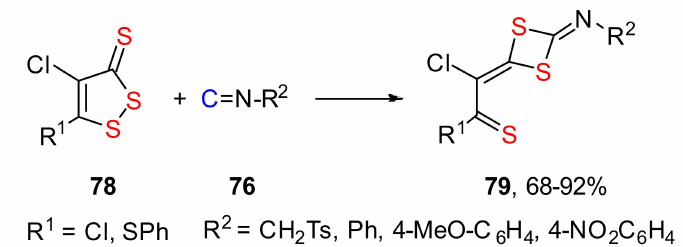
Scheme 49. Synthesis of 1,3-dithiethanes 79